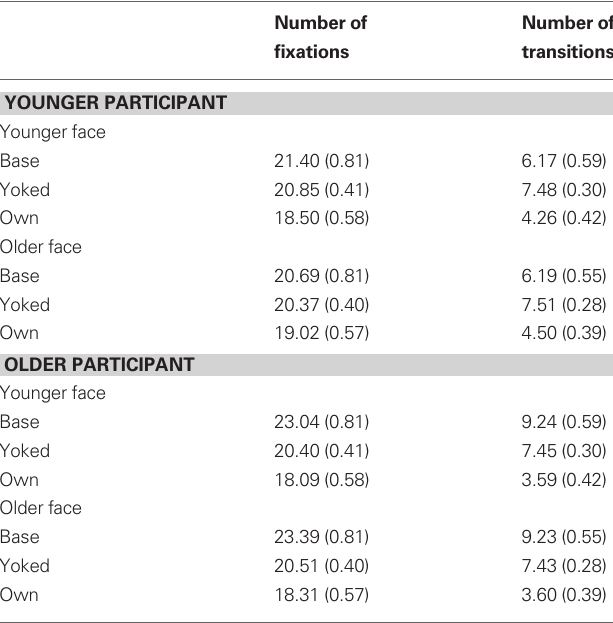
Table 3 | Mean (SE) number of fixations and transitions made to younger and older faces during the study block for younger and older participants across the different viewing